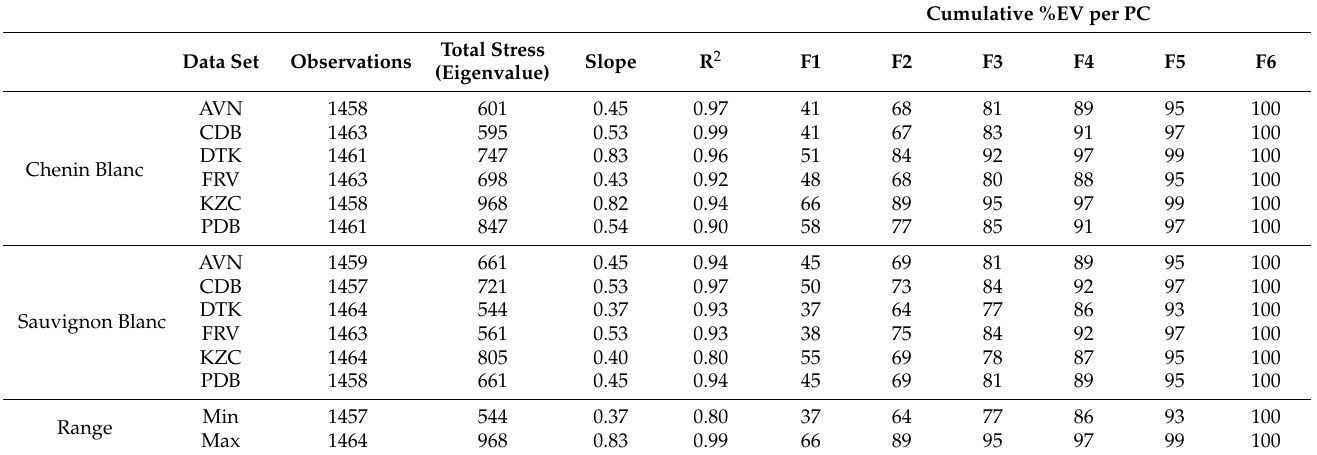
Table 4. Performance indicators and stress distribution of the mid-level PCA data fusion